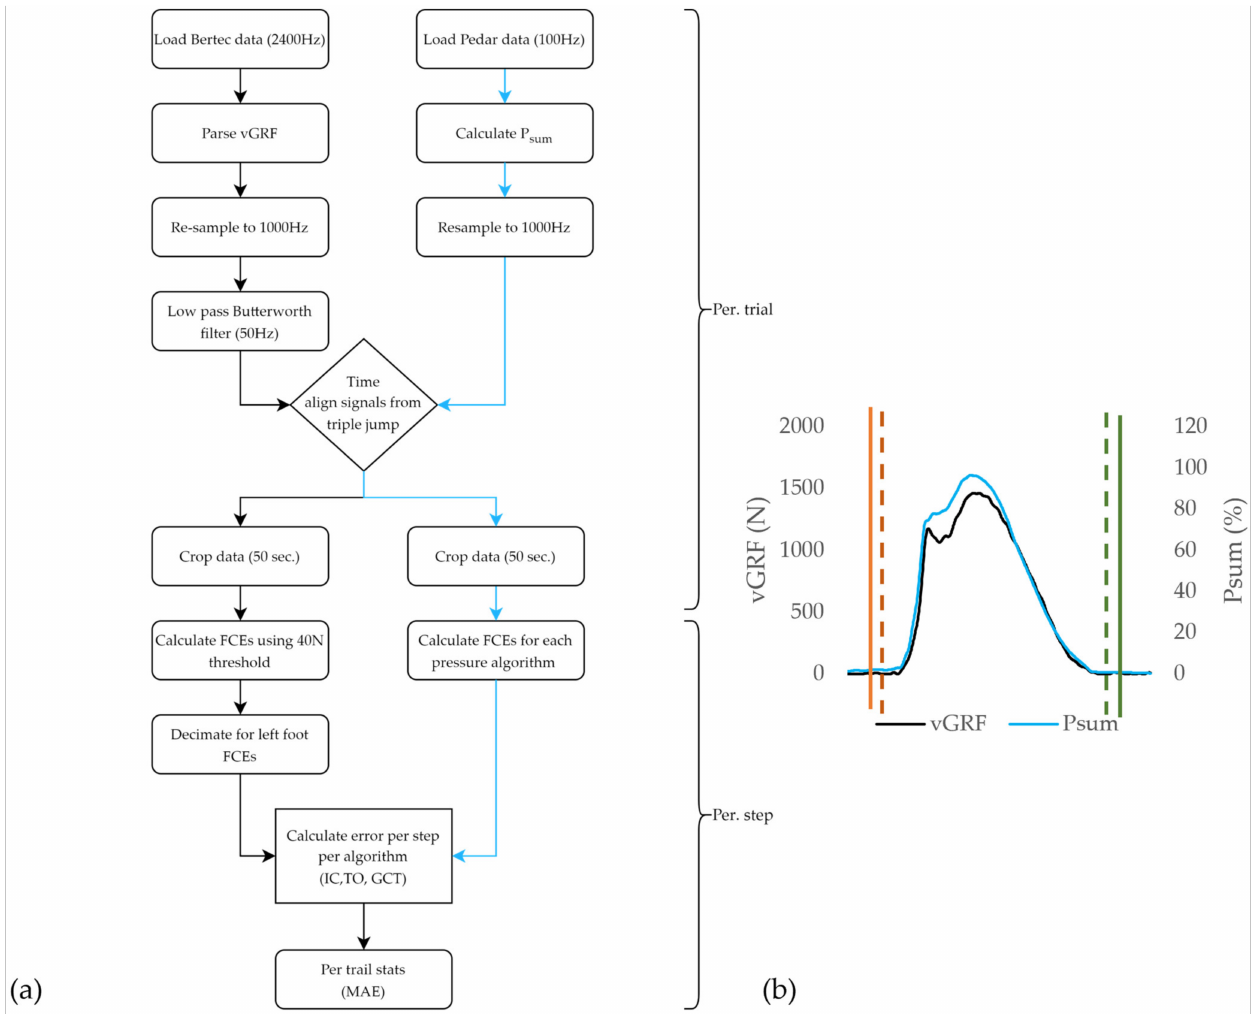
Figure 2. ( a ) Data processing (N = 18) flowchart detailing the processing of the reference vGRF data from the force instrumented treadmill (black) and P sum data from the PPMSs (blue) for each trial and for each stance within a given trial. ( b ) Single stance with overlayed vGRF signal (black) and P sum (blue). Overlayed reference of vGRF initial contact events (red dashed) and reference vGRF toe off events (green dashed) FCEs, as determined using the P sum signal using a given FCE algorithm (solid orange for initial contact and solid green for toe